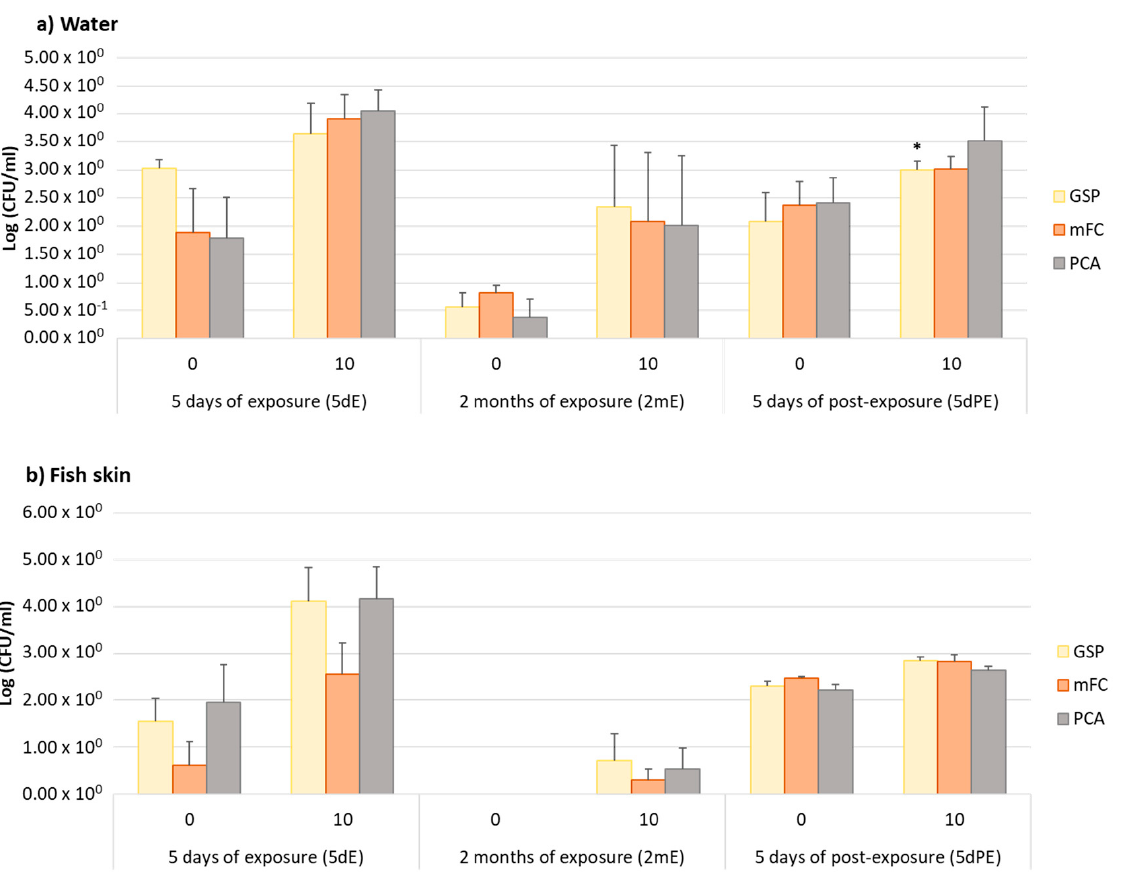
Figure 1. Total counts (Log (CFU/mL)) of antibiotic-resistant bacteria from nonexposed (0 µ g/L) and oxytetracycline (OTC)-exposed (10 µ g/L) samples at each sampling time (5 days of exposure: 5 dE; 2 months of exposure: 2 mE and 5 days of postexposure: 5 dPE). Counts were determined in selective media (Glutamate Starch Phenol Red Agar (GSP), Membrane Fecal Coliform agar (mFC) and Plate Count Agar (PCA)) supplemented with tetracycline (TET) at 16 µ g/mL. Asterisks (*) represent statistically significant differences ( p ≤ 0.05) towards the respective control (nonexposed water and fish skin).